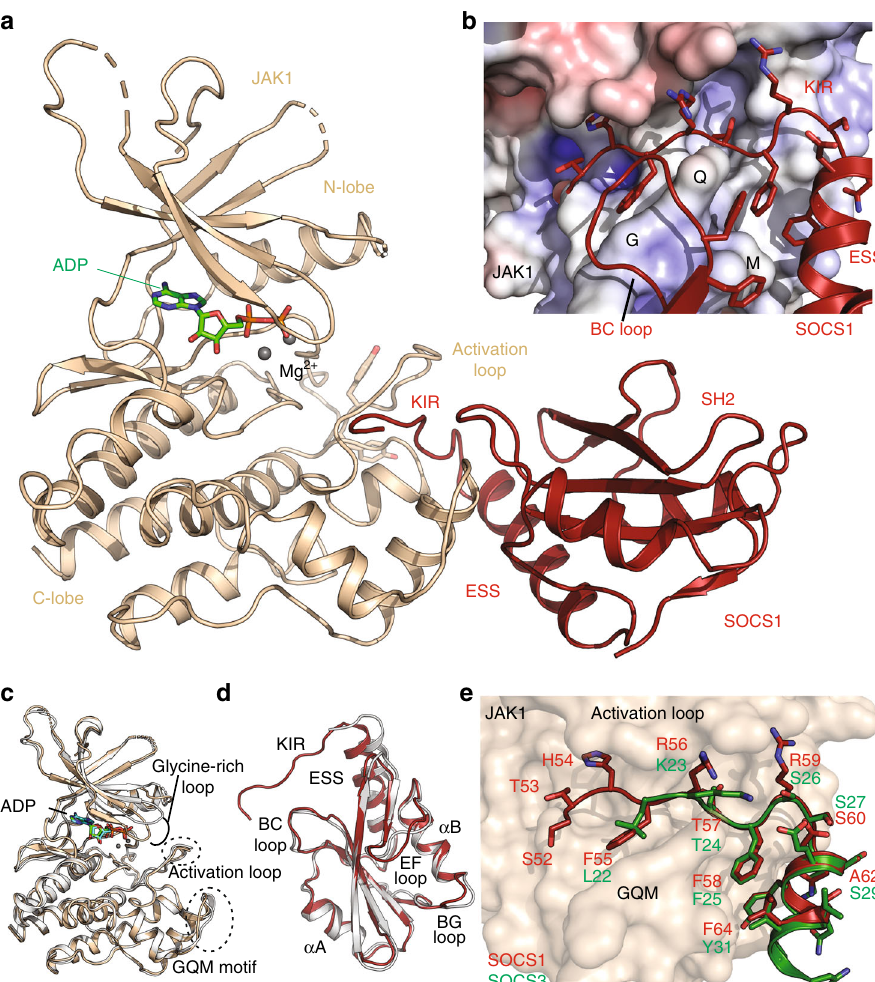
Fig. 2 The structure of a SOCS1/JAK1/ADP complex. a Cartoon representation of the JAK1 (beige) /SOCS1 (red) /ADP (green) complex. The SOCS1 kinase inhibitory region (KIR), the extended SH2 subdomain (ESS) as well as the SH2 domain proper (but not its phosphotyrosine-binding groove) all make substantial contacts with the C-lobe of the JAK1 kinase domain. Notably, JAK1 Tyr 1034 and 1035 in the activation loop are unphosphorylated in this structure. b Details of key SOCS1 interactions centred around the JAK1 GQM motif (electrostatic surface view). c JAK1 from the JAK1/SOCS1/ADP complex structure (beige) is shown overlaid with a JAK1/ADP structure (white, PDB: 5KHW). Small perturbations in the JAK1 activation loop and GQM motif can be seen between the two structures as well as a larger perturbation in the glycine-rich loop. The JAK1 activation loop is seen in the active conformation both in the presence and absence of SOCS1, despite being unphosphorylated in the SOCS1 bound structure. d Ribbon diagram of the structure of SOCS1 in the presence (red) and absence (white) of JAK1. The major conformational change to SOCS1 upon JAK1 binding is an ordering of the kinase inhibitory region. e The SOCS1 KIR is shown overlaid with the SOCS3 KIR (green) (PDB ID: 4GL9). Residue numbering of SOCS1 orthologues in all fi gures refers to the analogous residue in the human